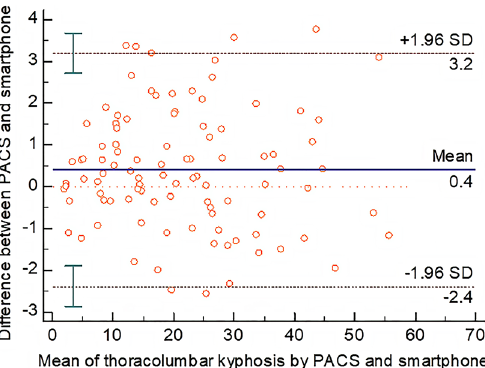
Figure 3. Bland–Altman plot. The solid line in the centre represents the mean difference, and the two outer dotted lines represent the limits of agreement (95% confidence interval).